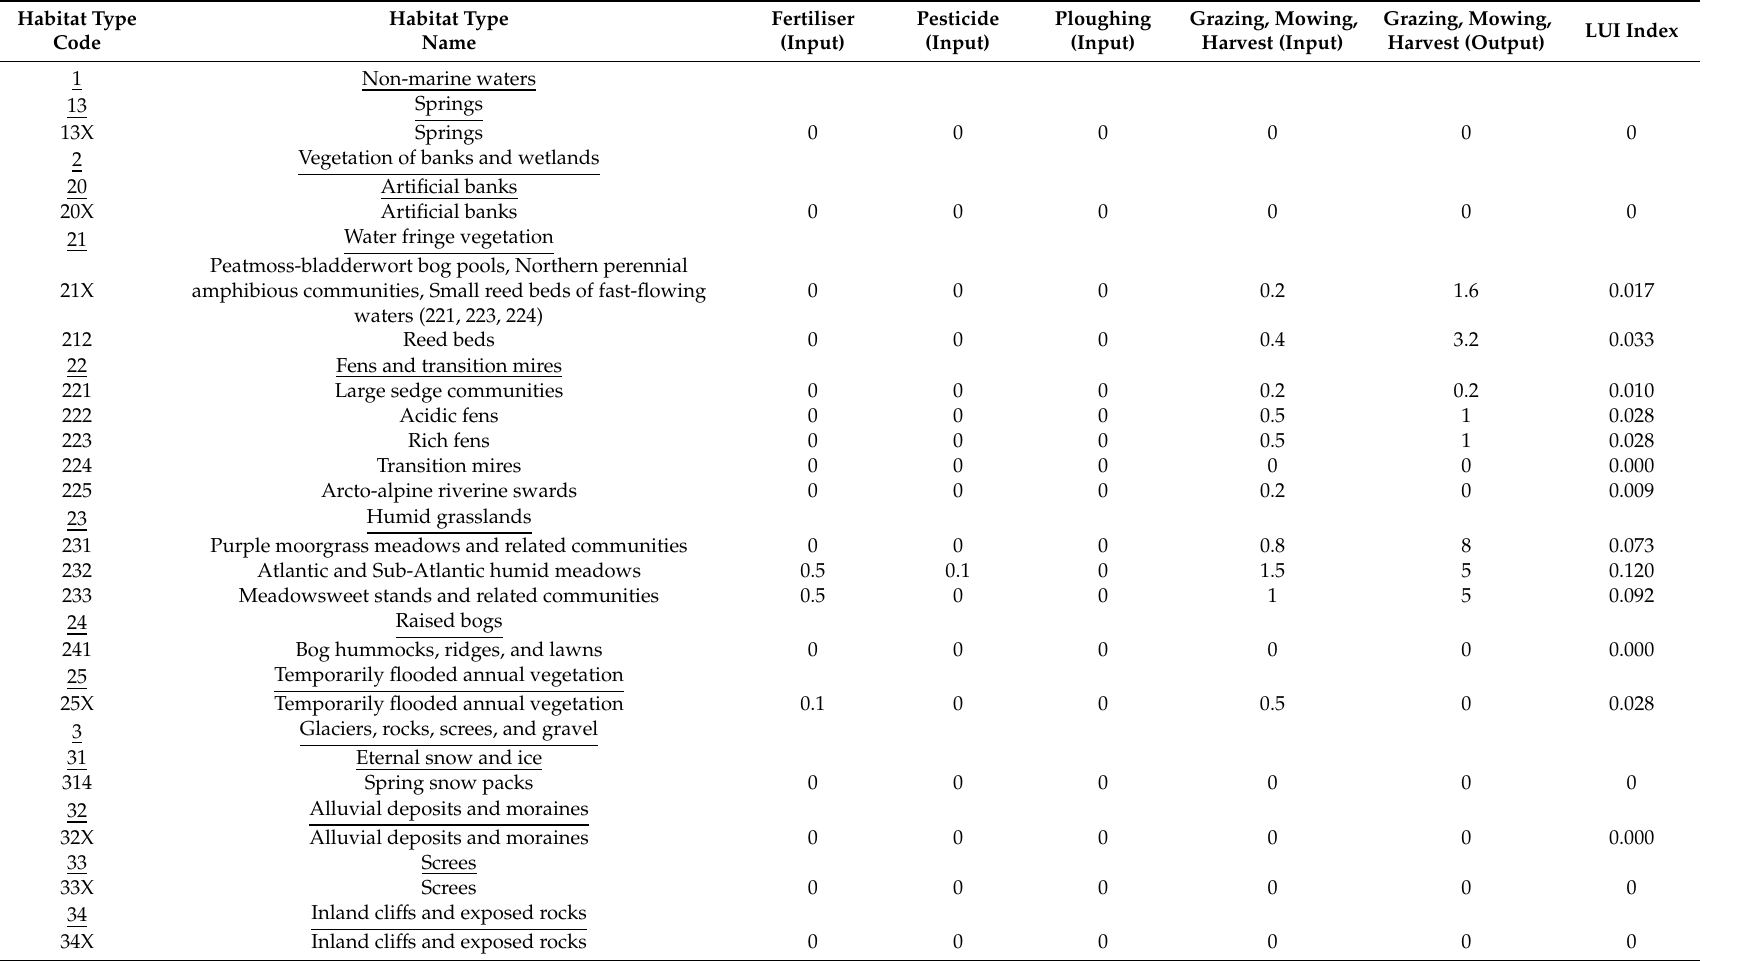
Table A1. Ratings of the land-use intensity factors and the combined LUI index per habitat type. Habitat type headings are